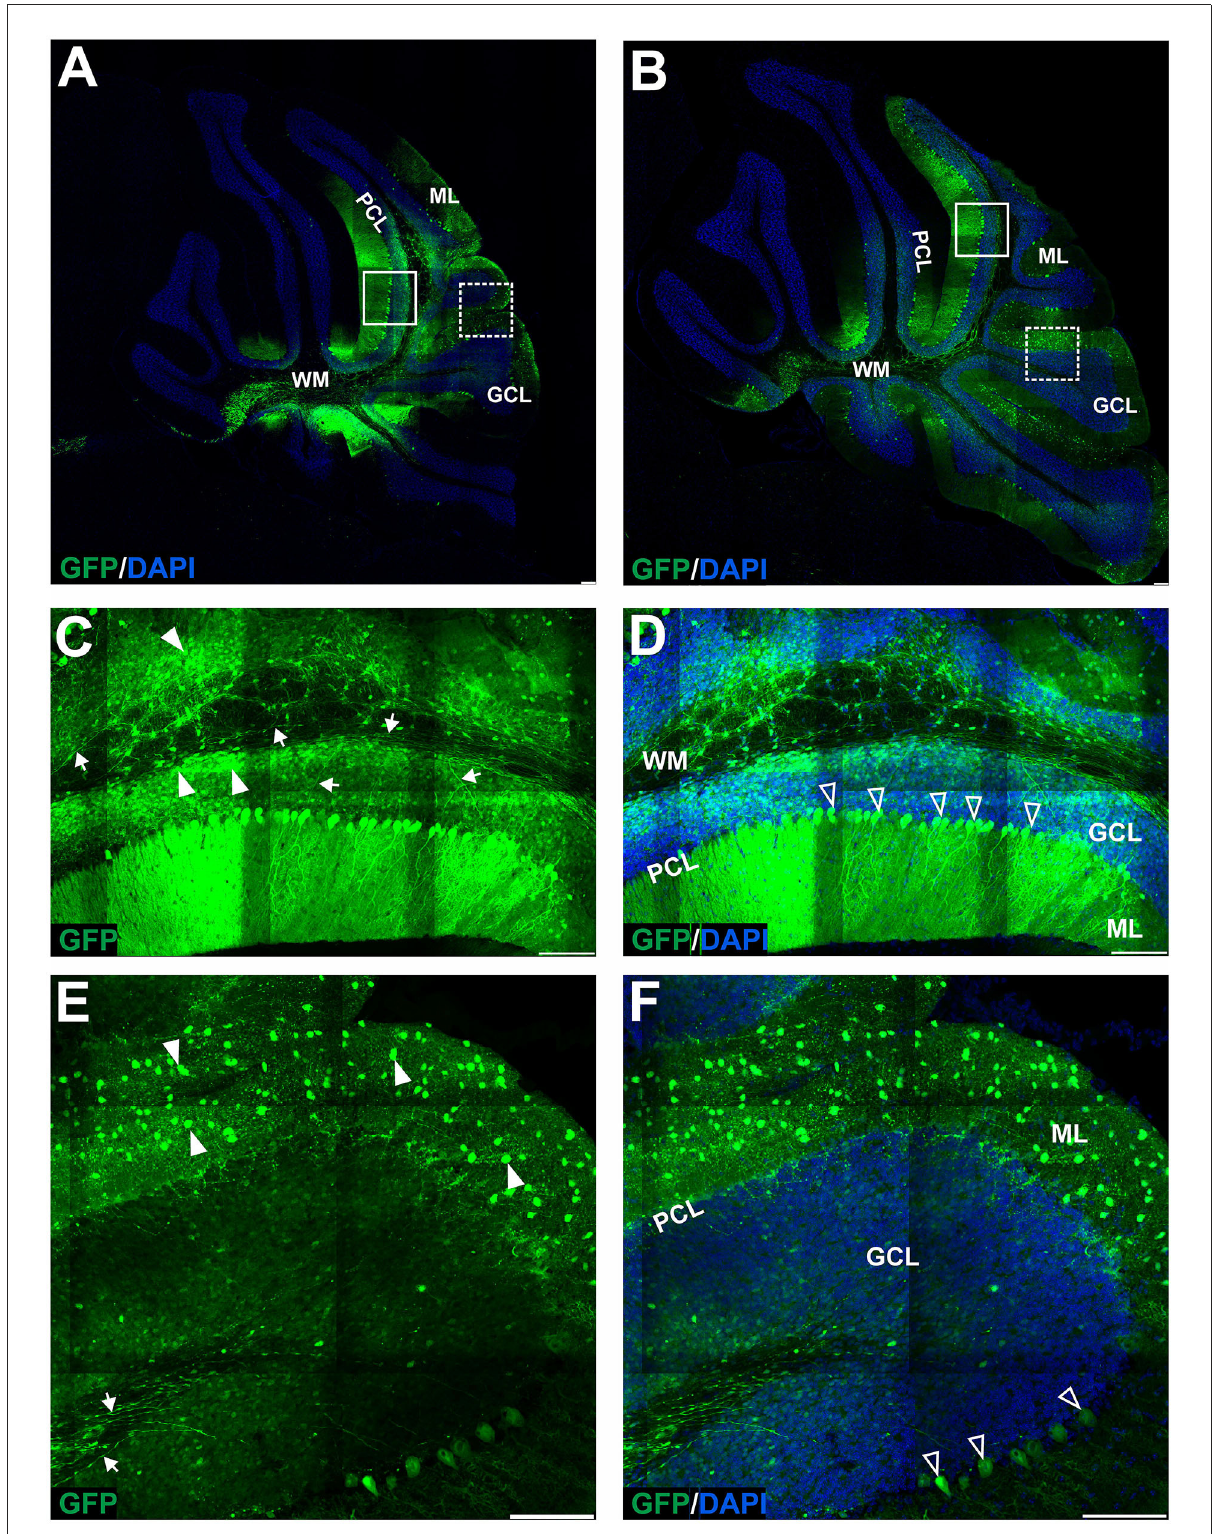
FIGURE5 The transduction of the mouse cerebellum after injection of the eGFP-encoding AAV-PHP.eB vector into the cerebellar lobules. Green signal in eGFP + cells on the sagittal sections was evident at 4 (A,C–F) and 7 (B) weeks after injection. Two transduction patterns were observed: pattern